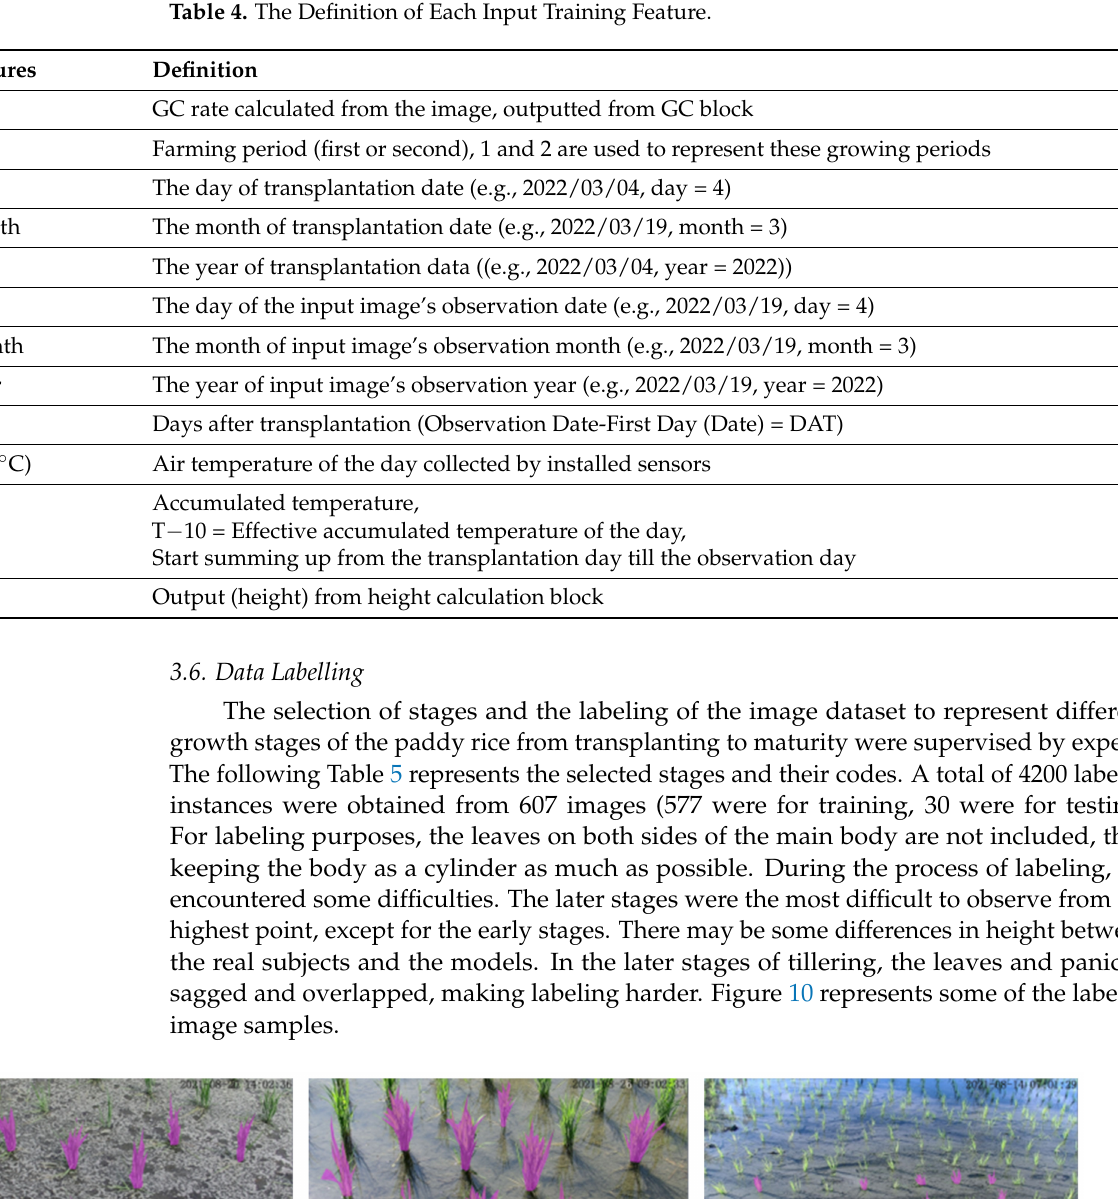
Table 4. The Definition of Each Input Training Feature.